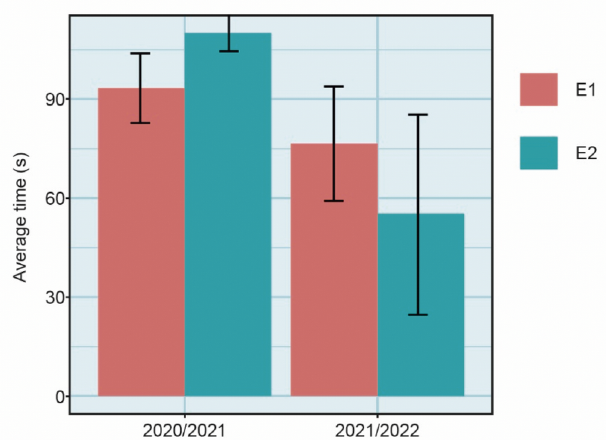
Figure 2. Average value and typical deviation in the time taken by students to answer in